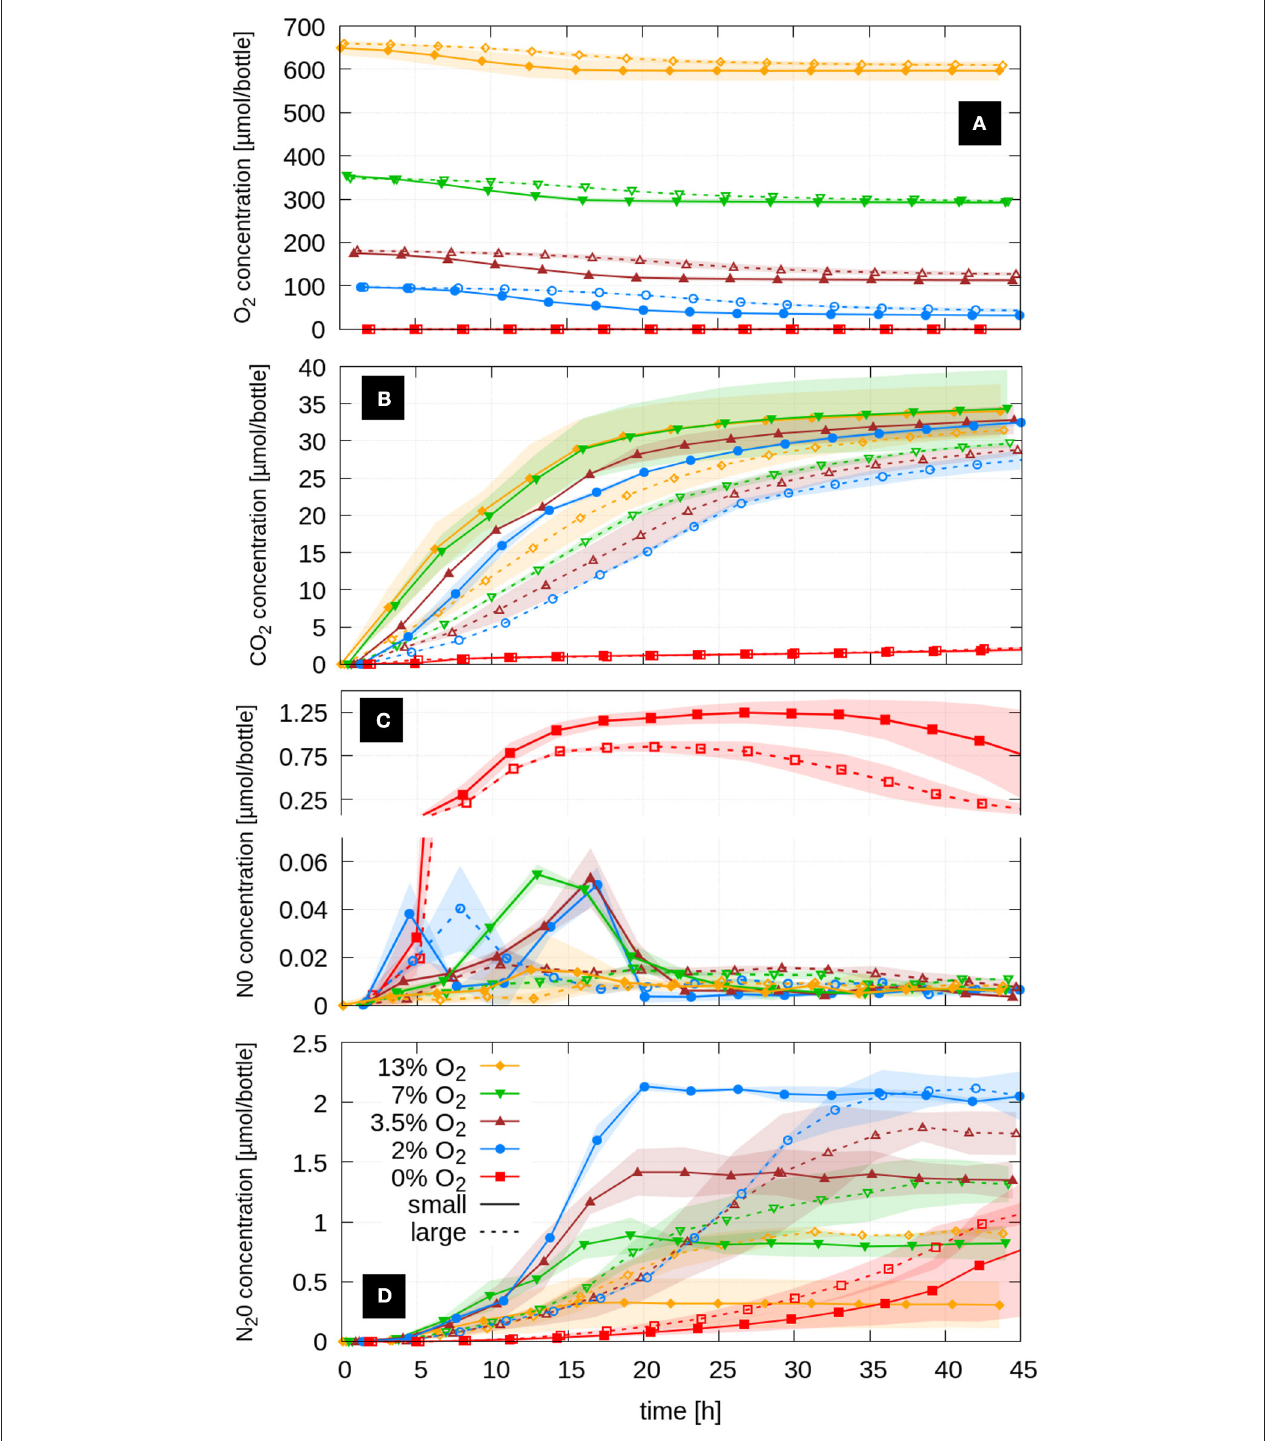
FIGURE 2 | Respiration kinetics of A. tumefaciens in small and large aggregates at five initial oxygen concentrations shown as average headspace concentrations ( n = 2) of (A) O 2 , (B) CO 2 , (C) NO and (D) the final denitrification product N 2 O. Shaded areas represent standard deviations.